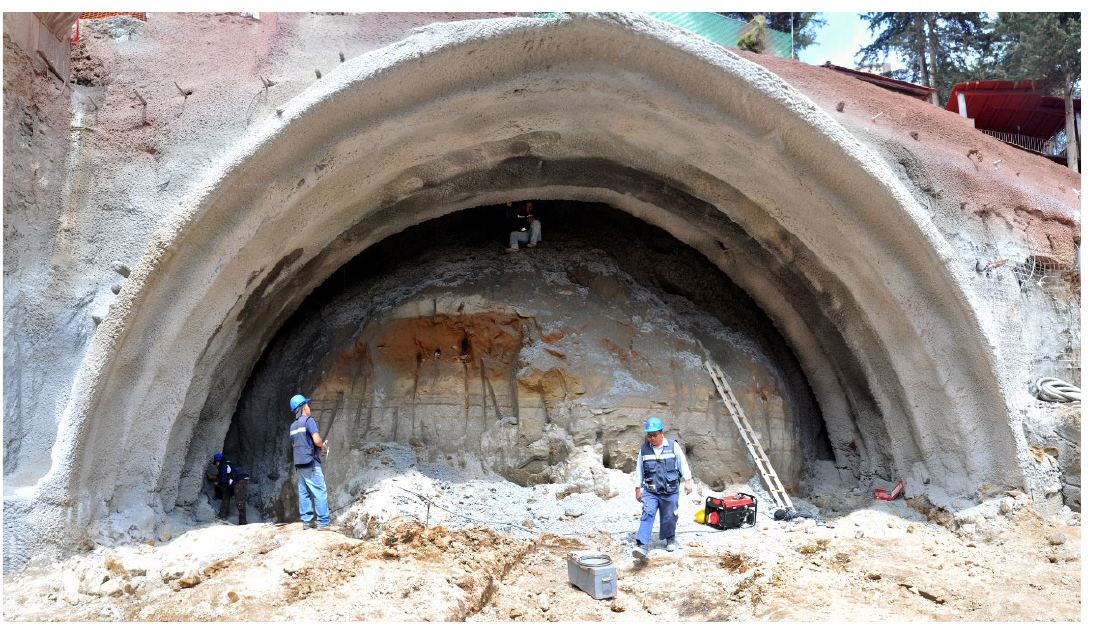
Figure 27. Detail of the excavation of the left tube of the South Portal, where there was the least coverage (8 m).